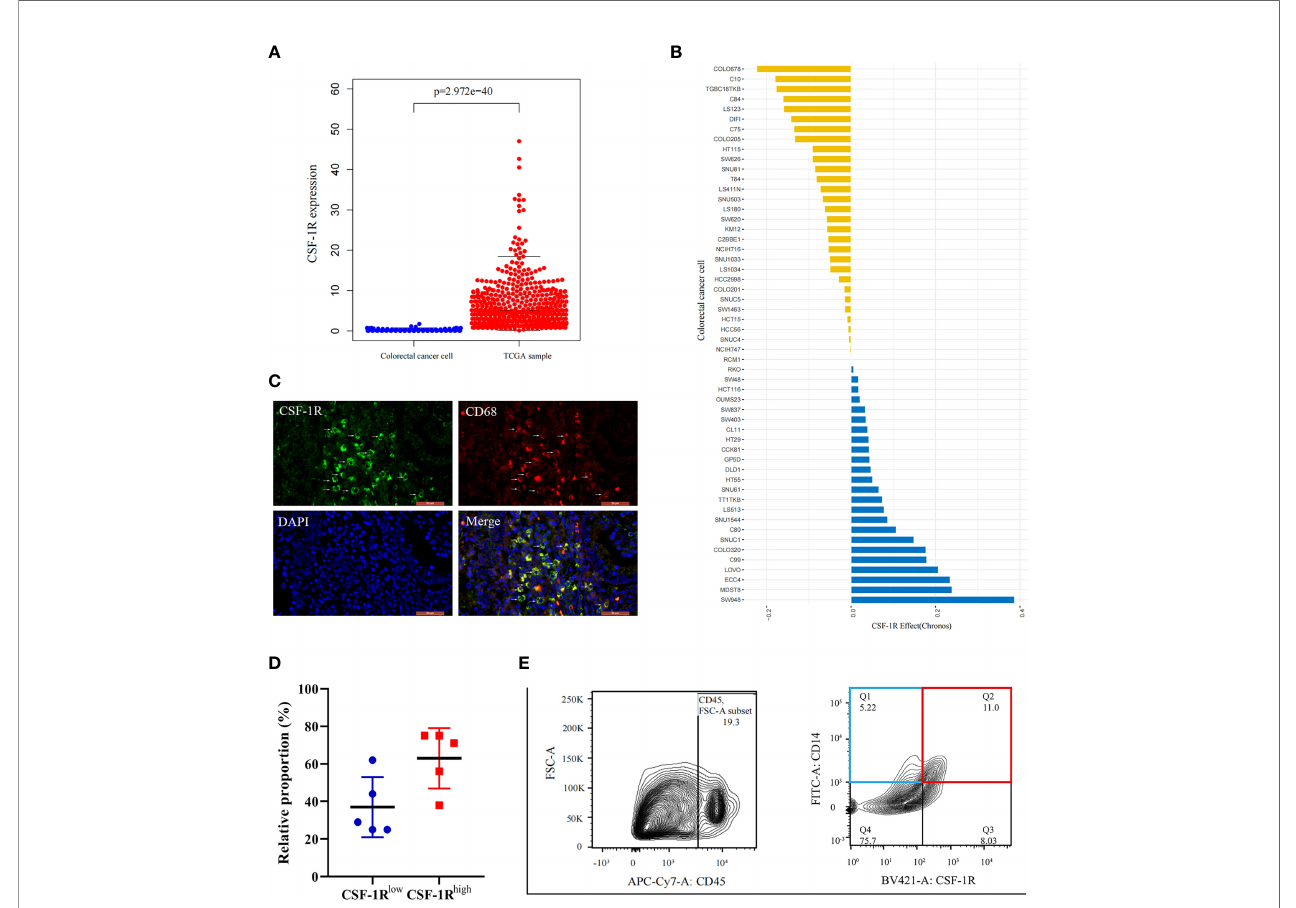
FIGURE 2 | Characterization of CSF-1R distribution in COAD tissues and tis perturbation effects in CRC cells. (A) .The boxplot shows the difference of CSF-1R expression between the TCGA samples and established colorectal cancer lines. (B) CSF-1R perturbation effects in CRC cells (A score of 0 is equivalent to a gene that is not essential whereas a score of -1 corresponds to the median of all common essential genes). (C) Immuno fl uorescence staining of CD68 and CSF-1R in COAD specimen. (D) The proportions of CSF-1R low TAMs and CSF-1R high TAMs in COAD specimen. (E) Representative fl ow cytometric plot of the sorted CSF- 1R low TAMs and CSF-1R high